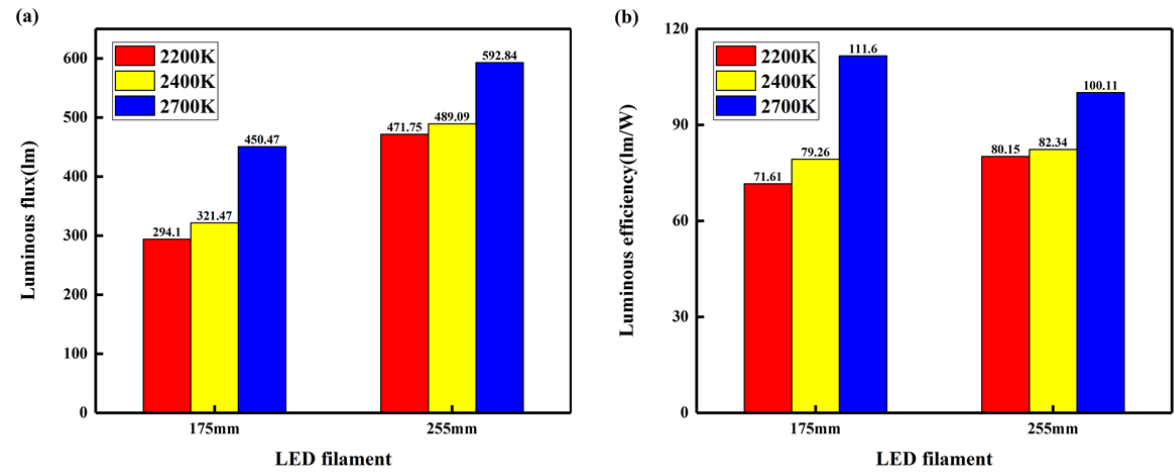
Figure 3. ( a ) Luminous flux of three CCTs LED filaments after steady state; ( b ) Luminous efficiency of three CCTs LED filaments after steady state.